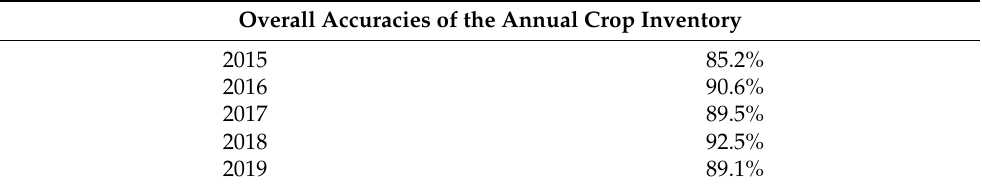
Table 1. Overall accuracies of the Annual Crop Inventory in Nova Scotia (adapted from Agriculture and Agri-Food Canada [29]).